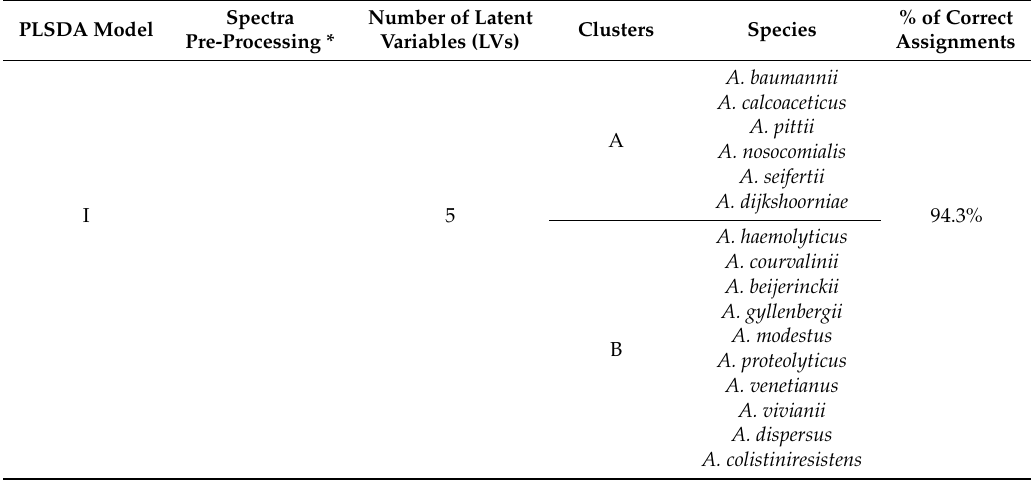
Table 1. Details of the first PLSDA model developed for Acinetobacter species discrimination.